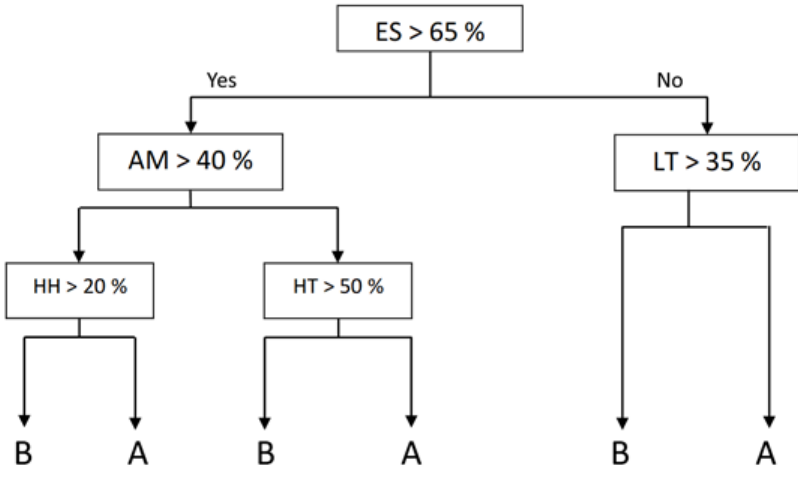
Figure 8. Decision Tree obtained training the algorithm with a simulated